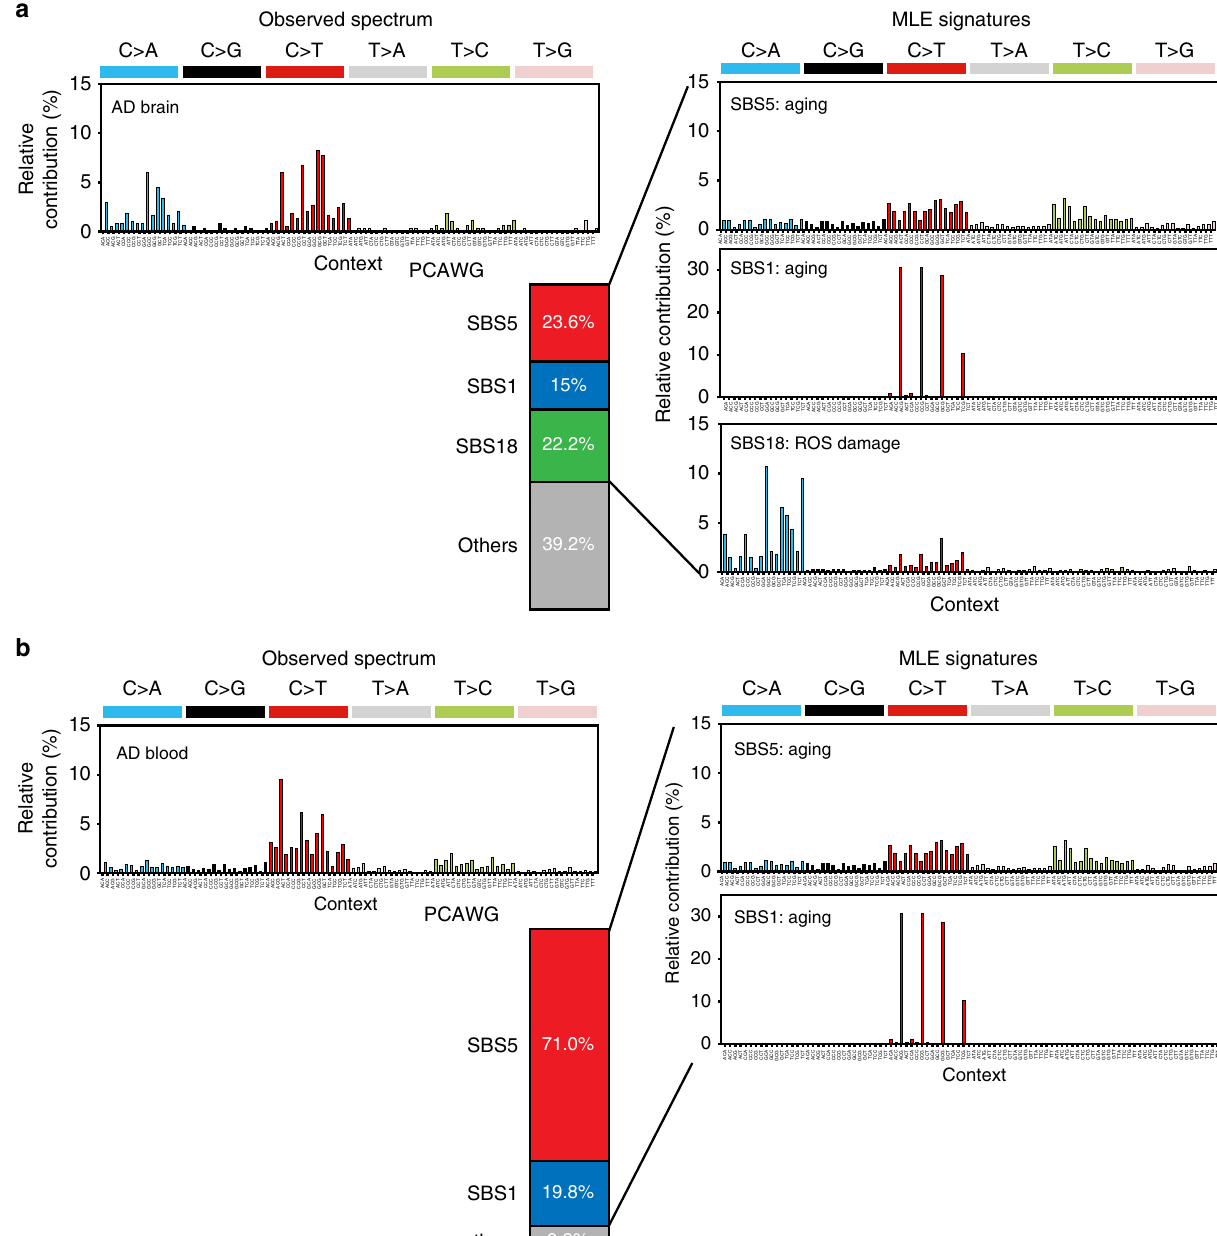
Fig. 2 Mutation signatures of brain and blood somatic mutations in Alzheimer ’ s disease (AD). The best decomposed mutation signature models from multiple likelihood estimation were derived for each tissue along with actual distribution of 96 possible mutation types. a Single base substitution (SBS) signatures 5, 1, and 18 and others account for 23.6%, 15%, 22.2%, and 39.2% of brain somatic mutations in AD, respectively. b SBS signatures 5 and 1, and others account for 71.0%, 19.8%, and 9.2% of blood somatic mutations in AD,